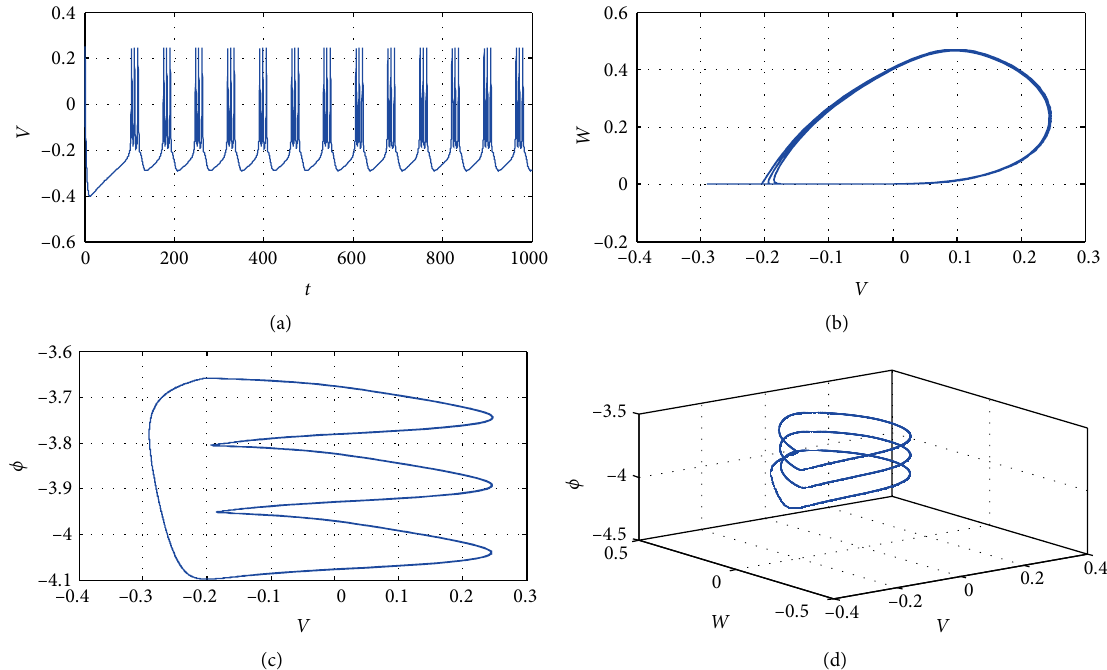
Figure 4: Sampled time series for membrane potential and phase diagrams when the system parameters are selected as 𝐼 = 0 , 𝑘 𝑘 2 = 0.15 , and 𝑘 3 = 0.15